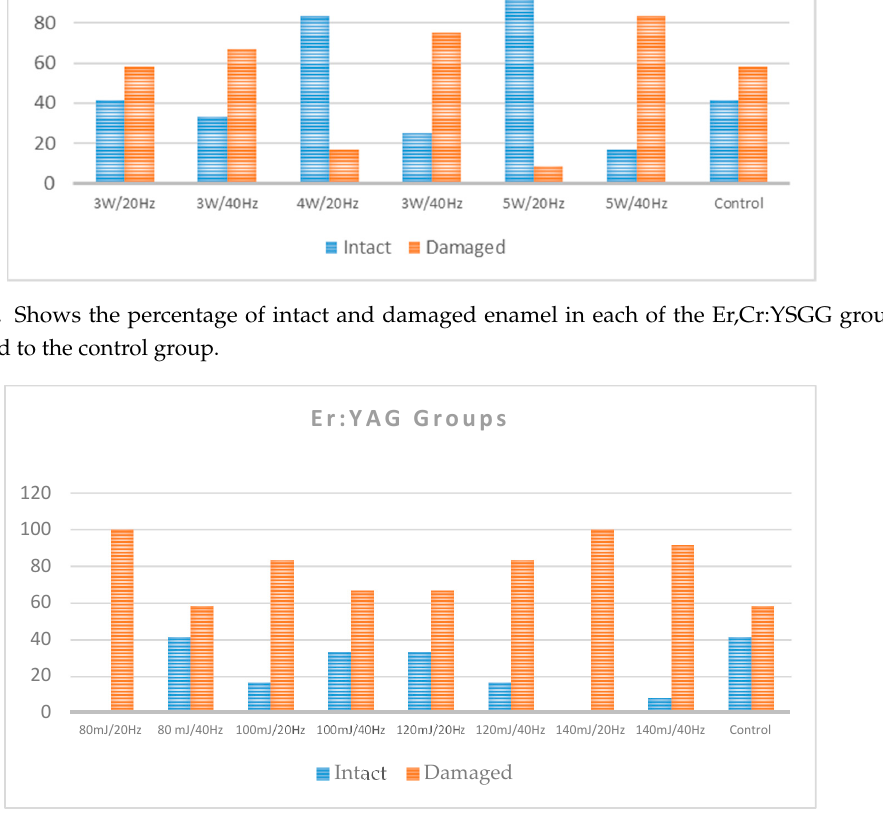
Figure 6. Shows the percentage of intact and damaged enamel in each of the Er:YAG groups compared to the control group.